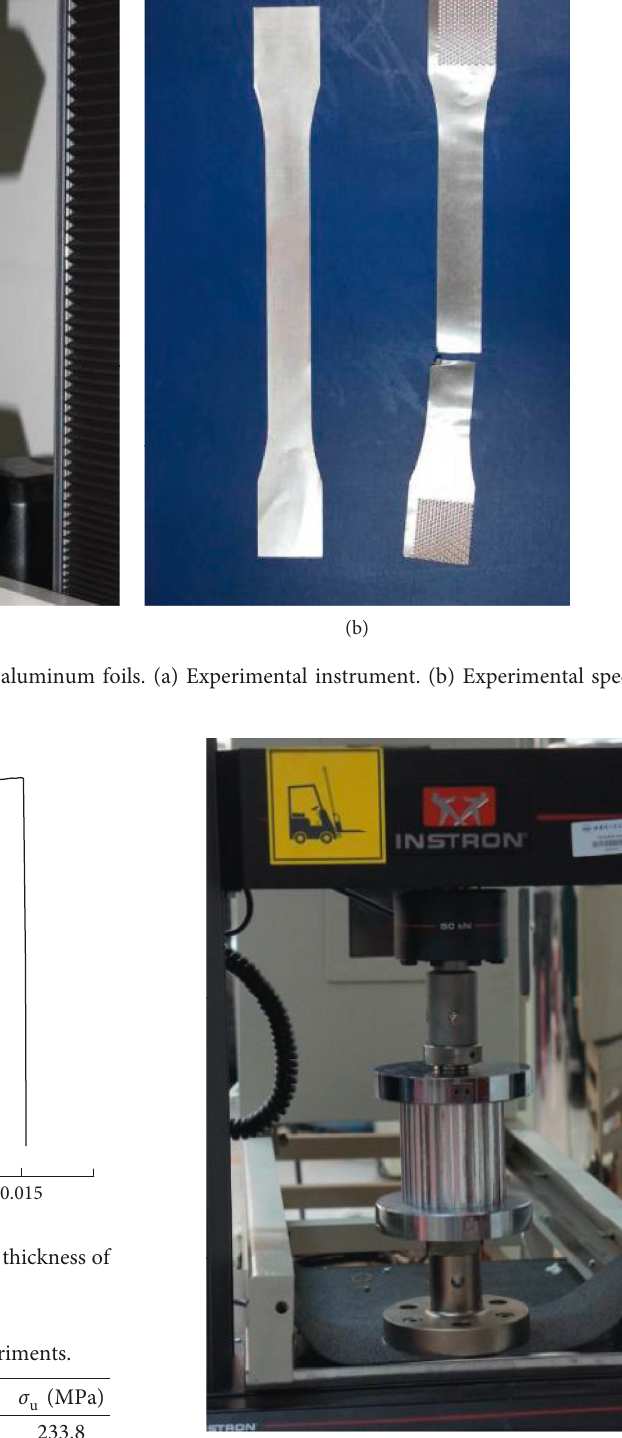
Figure 9: Quasi-static experiment